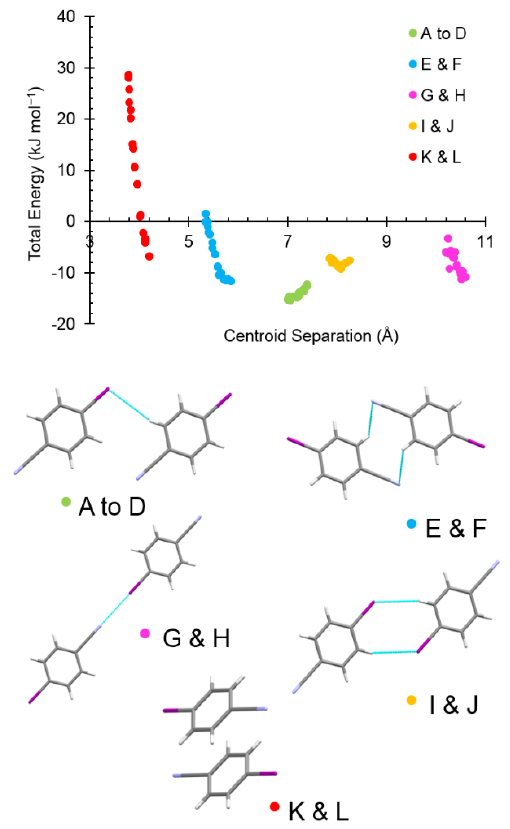
Figure 5. Graph of total interaction energy for the five most energetically significant dimers in 4-iodobenzonitrile phase I as a function of molecular centroid separation. The dimers shown are those of the ambient pressure structure.